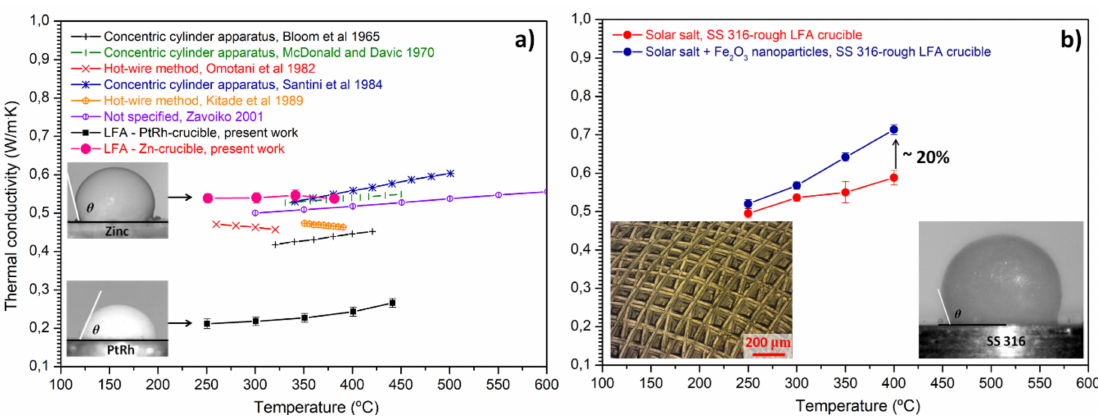
Figure 5. ( a ) Thermal conductivity of Solar salt measured by LFA using PtRh-and Zn-crucibles; Inserts: contact angles of Solar salt on the surface of the PtRh-and Zn-LFA crucibles. ( b ) Thermal conductivity of Solar salt and Solar salt-based nanofluid measured by LFA using rough SS 316-crucible; Inserts: contact angle of Solar salt on the surface of SS 316 crucible and optical image of the surface of SS 316